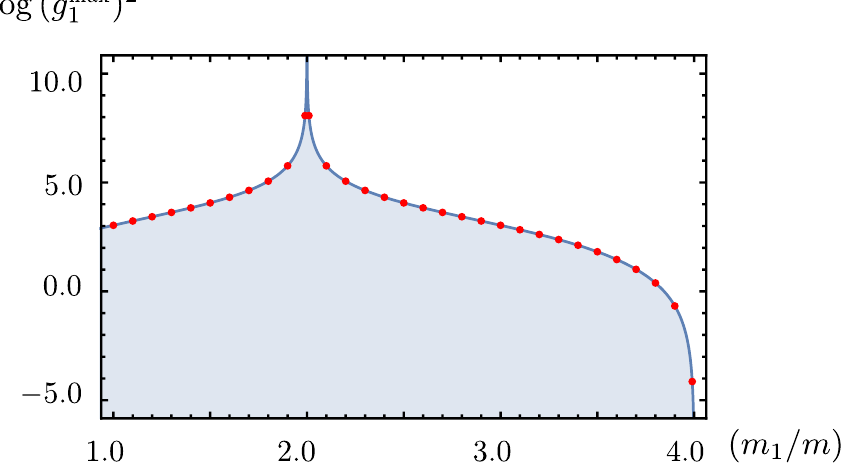
Figure 4 . Maximum cubic coupling g max between the two external particles of mass m and the 1 exchanged particle of mass m 1 . Here we consider the simplest possible spectrum where a single particle of mass m 1 shows up in the elastic S-matrix element describing the scattering process of two mass m particles. The red dots are the numerical results. The solid line is an analytic curved guessed above (2.9) and derived in the next section. The blue (white) region corresponds to allowed (excluded) QFT’s for this simple